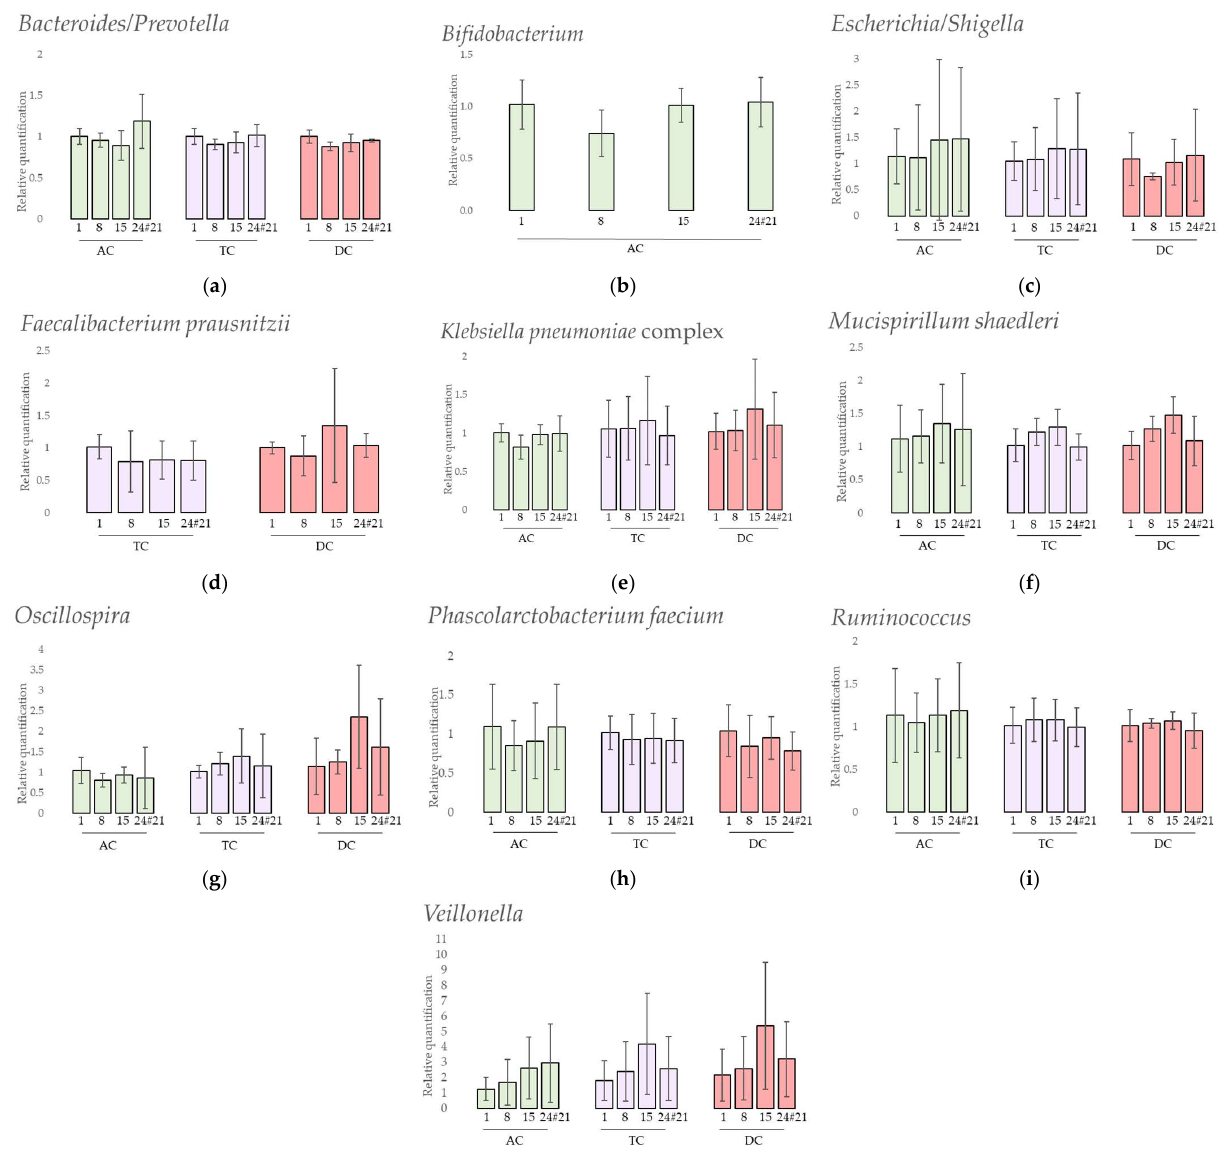
Figure 8. Relative quantification of 10 selected taxa ( a ) Bacteroides/Prevotella , ( b ) Bifidobacterium , ( c ) Escherichia/Shigella , ( d ) Faecalibacterium prausnitzii , ( e ) Klebsiella pneumoniae complex, ( f ) Mucispirillum schaedleri , ( g ) Oscillospira , ( h ) Phascolarctobacterium faecium , ( i ) Ruminococcus and ( j ) Veillonella assessed by qPCR analysis after one daily ULIP33 phage injection (10 mL at 10 9 PFU/mL) in the ascending colon for 7 days. Mean fold-changes (±SD) are presented and calculated using 2 −ΔΔCq method. AC: ascending colon; TC: transverse colon; DC: descending colon.